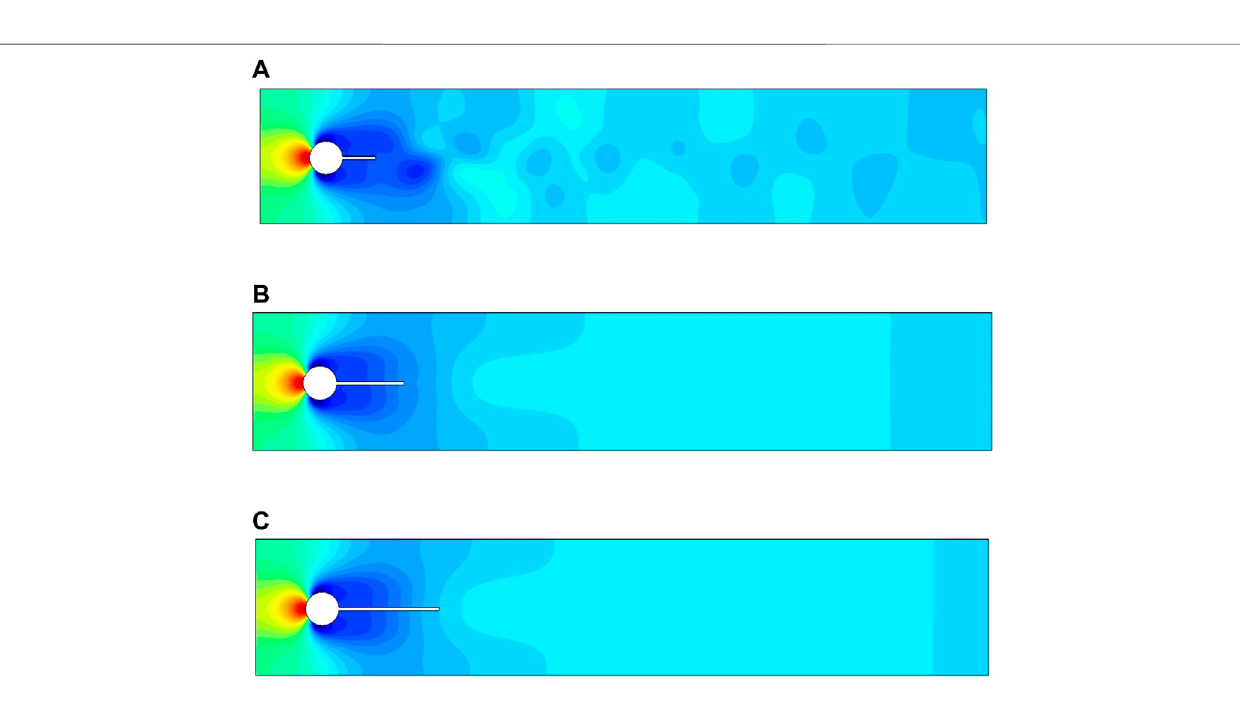
Frontiers in Physics |